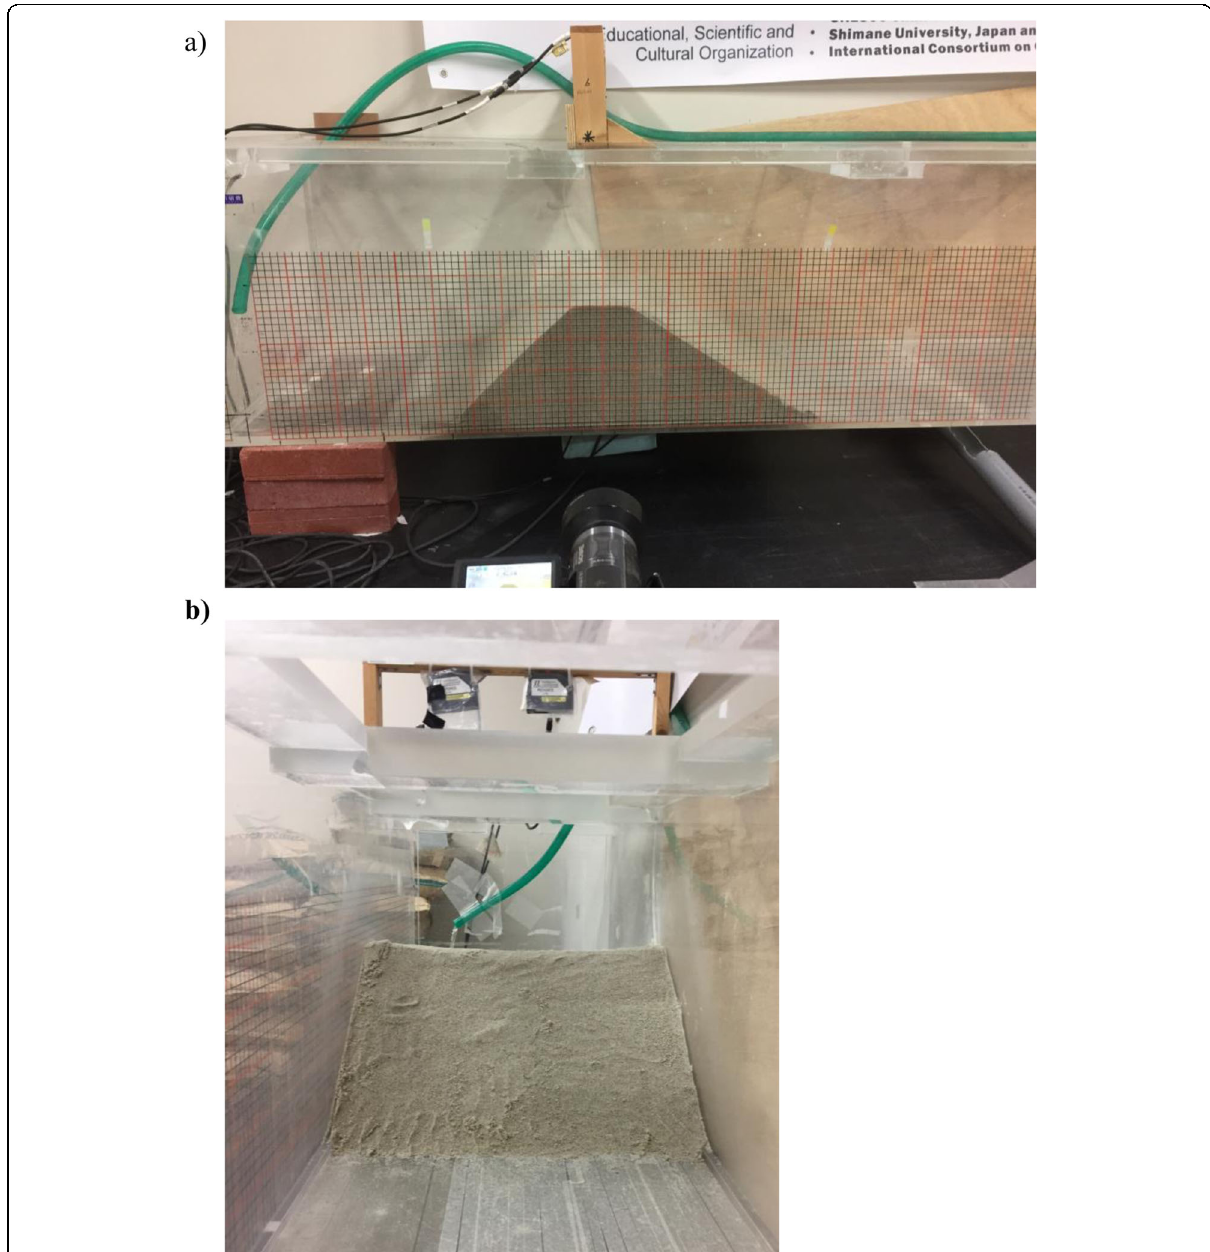
Fig. 15 Photographs of experimental setup. a Side view of flume tank during experiment. b Downstream slope of dam with laser sensor at the top of flume